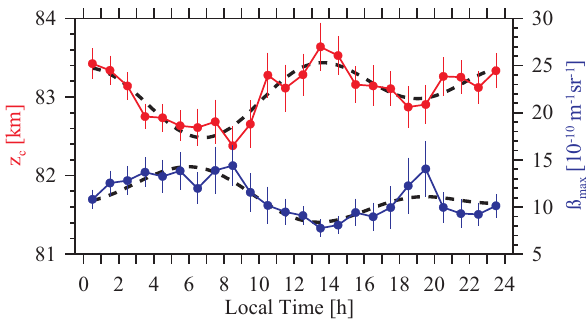
Fig. 3. Diurnal variation of NLC altitude (red circles) and brightness (blue circles) above ALOMAR for the integrated data set from 1997 to 2003. Only clouds brighter than β max > 4 × 10 − 10 m − 1 sr − 1 are included. The vertical bars repre- sent the 95% significance limits of the hourly mean values, and the dashed curves are harmonic fits to the